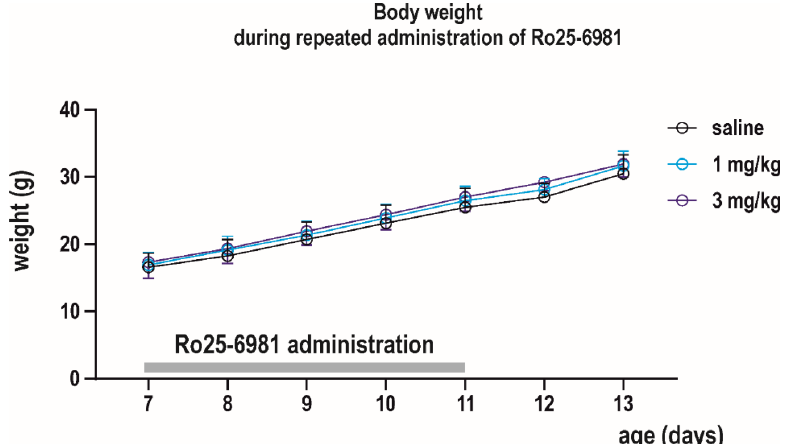
Figure 7. Effects of repeated administration of Ro25-6981 on body weight. Ro25-6981 was adminis- tered daily at P7–P11 ( x axis) in two doses of 1 and 3 mg/kg i.p. Body weight was checked daily till P13. Body growth (in grams, axis y ) was not affected by drug exposure.